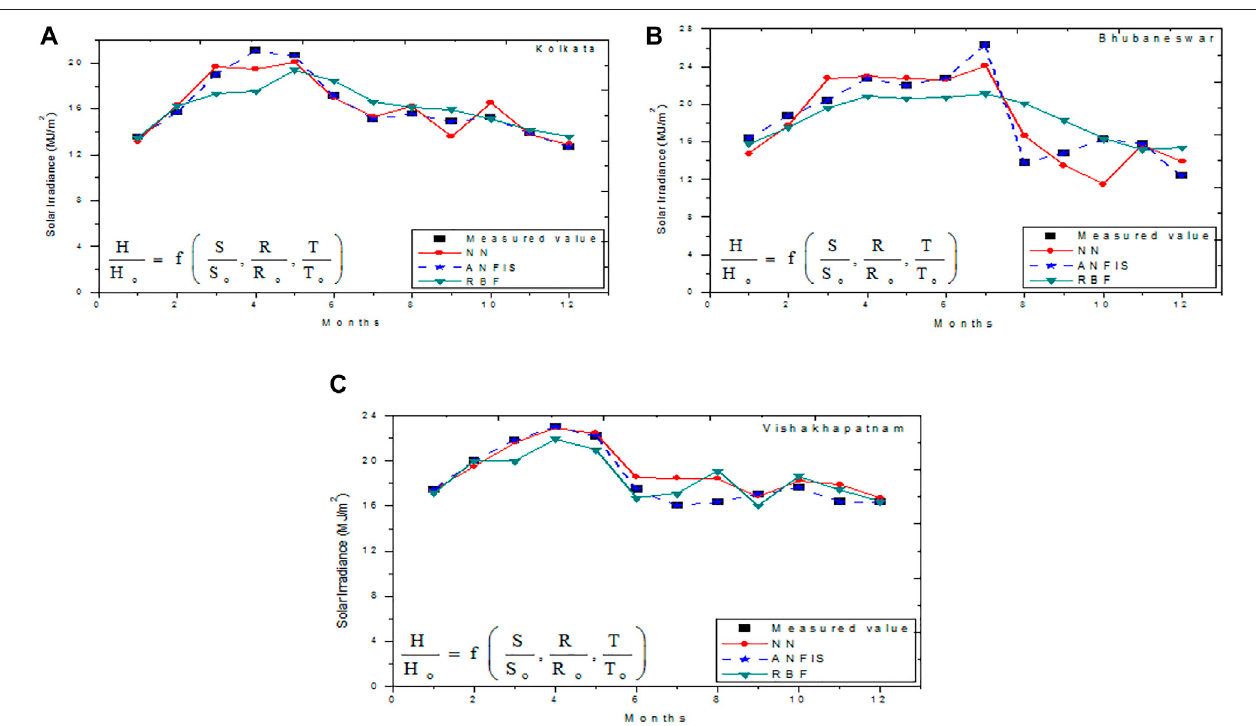
FIGURE 15 | (A – C) Measured and predicted data using different soft computing approaches for Visakhapatnam.